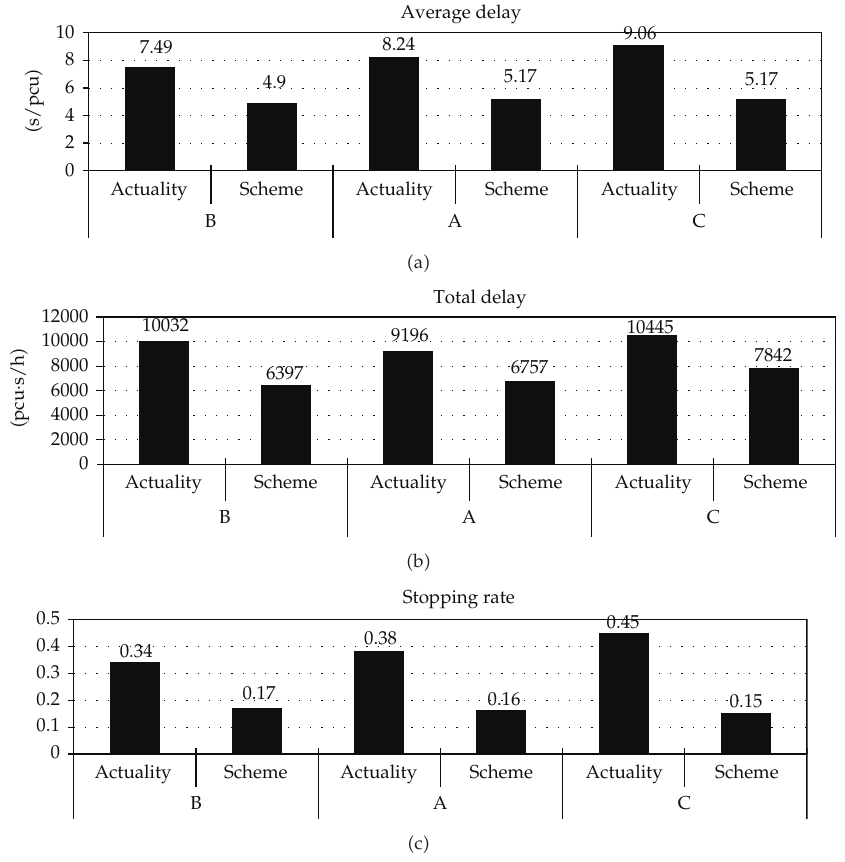
Figure 11: A comparison figure of vehicle delays from south to north of road actuality and scheme.